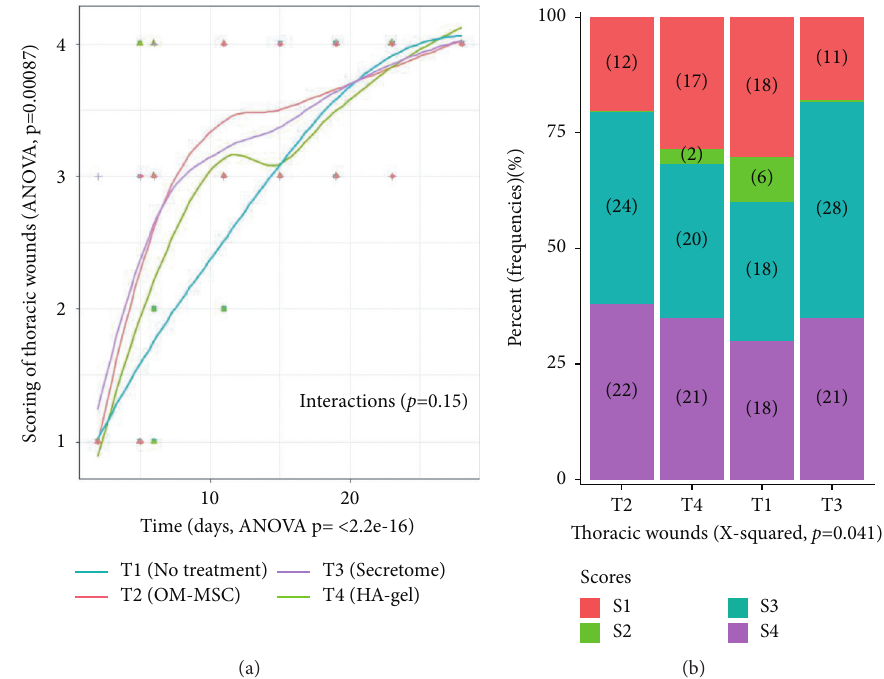
Figure 5: Thoracic wound noninvasive assessment. (a) Gross wound evaluation scoring evaluated by a Fisher two-way ANOVA. It shows a significant increase in score with time. (b) Cross frequencies between the levels of the wound and the different treatments investigated with bar plot and Pearson’s Chi-square test. T2 and T3 treatments applied to TH wounds showed an increase in level 3 score corresponding to increased wound contraction.